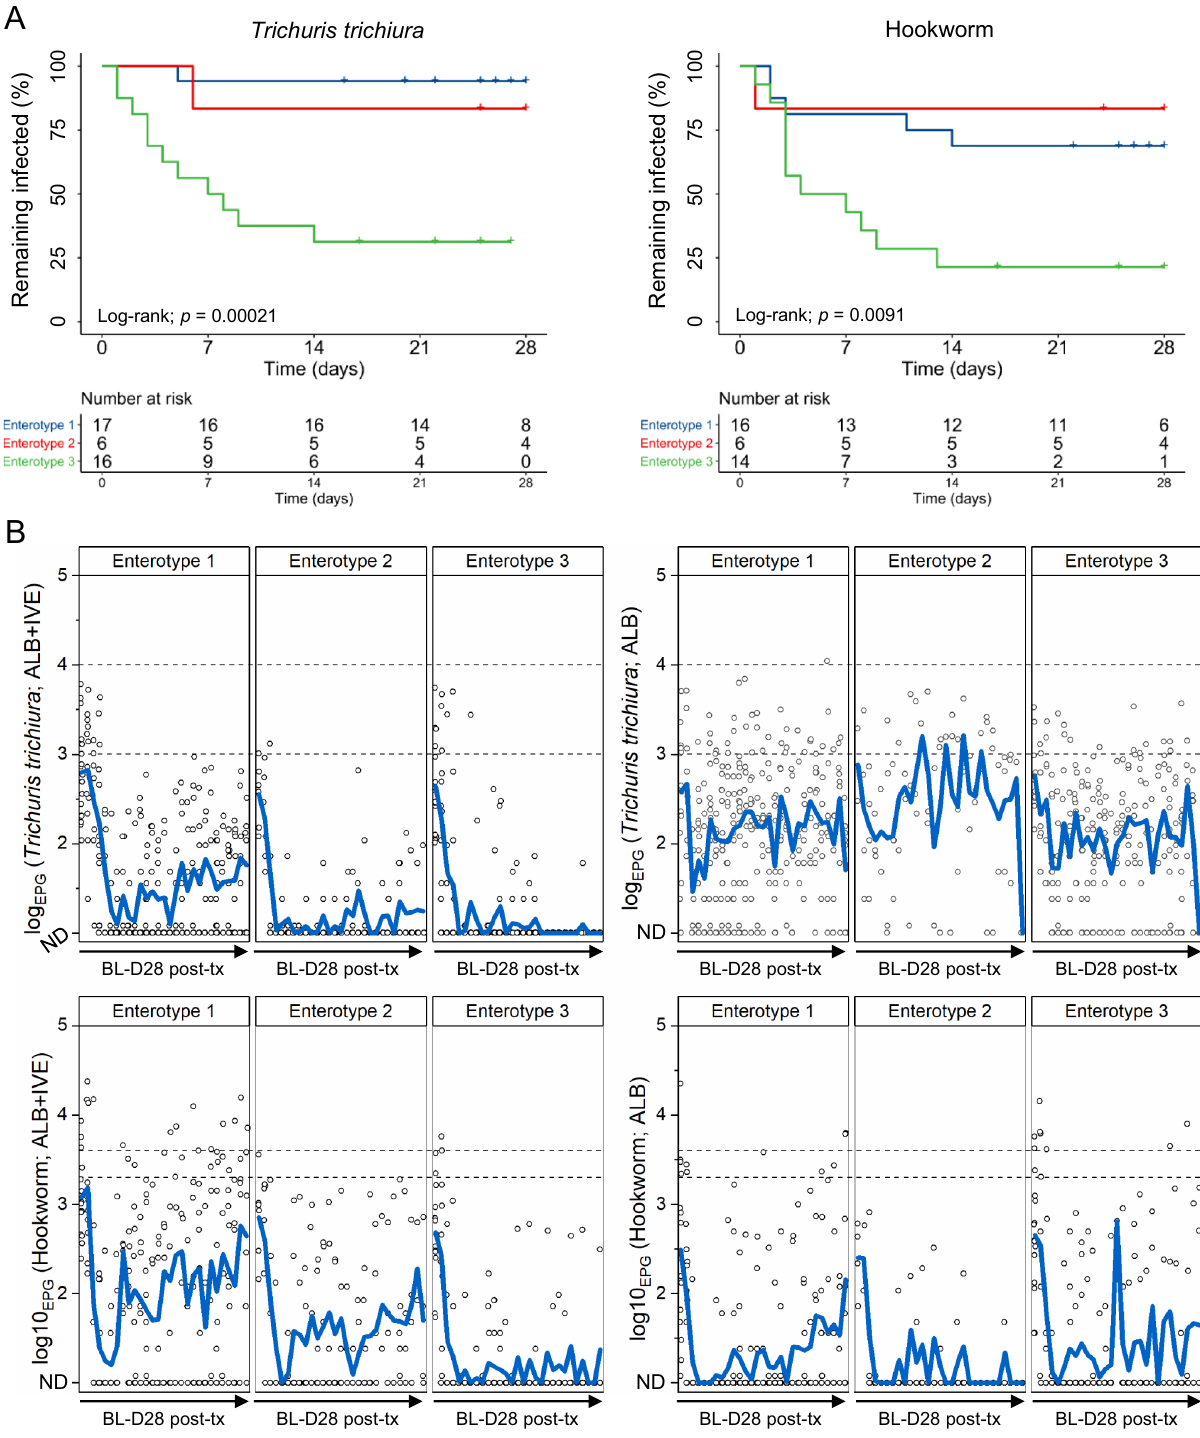
Fig. 5 Relationship between pre-treatment enterotype and daily post-treatment egg counts of Trichuris trichiura and hookworm. A Kaplan – Meier curve showing the remaining proportion of infected patients over time, strati fi ed by baseline enterotype. T. trichiura cure is shown on the left, while hookworm cure is shown on the right. B Averaged daily egg counts of T. trichiura (upper two panels) and hookworm (lower two panels) strati fi ed by pre-treatment enterotype. Daily egg counts are shown for the combination therapy (albendazole and ivermectin; left half panels) and monotherapy (albendazole; right half panels). The black dashed lines indicate the lower and upper thresholds of moderate infections for each parasite. ND not detected, post-tx post- treatment, ALB albendazole, IVE